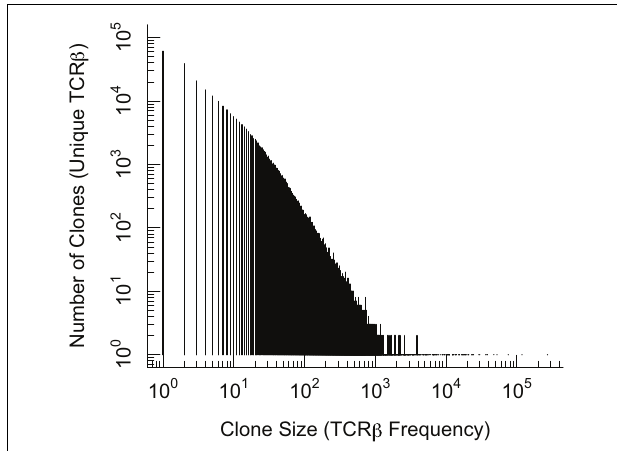
FIGURE 1 | Plot of the frequency distribution in the β chain sequences of naïve CD8 T cells . Naïve (CD44 lo ) CD8 T cells from C57Bl/6 mice were isolated by magnetic beads and > 98% purity confirmed by flow cytometry. Genomic DNA was subjected toTCR β V-J multiplex DNA sequencing and the distribution of unique in-frame CDR3 sequences is plotted.We note that the term “clone” on the x and y axis labels refers to clones based on β chain sequences